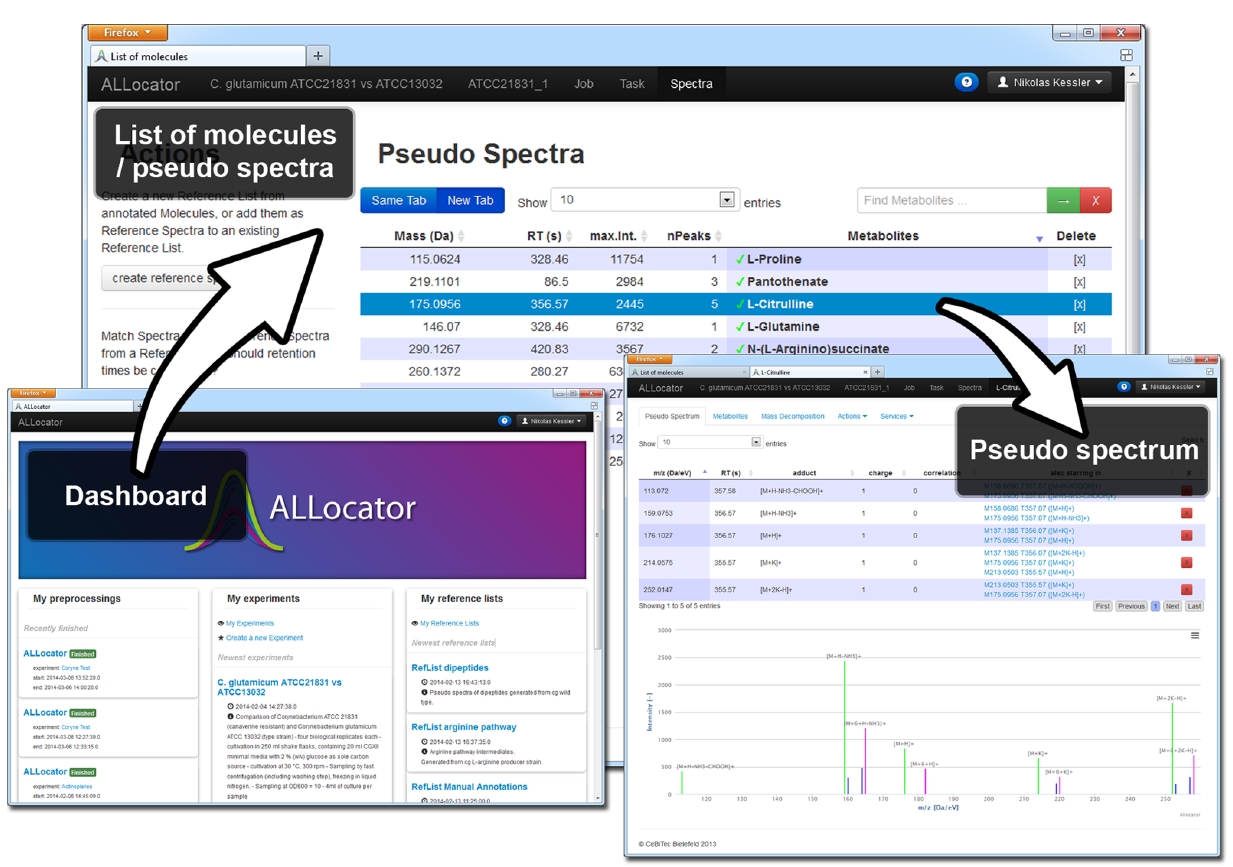
Figure 3. Screenshots from the ALLocator web platform user interface; bottom left: the dashboard that servers as a starting point after log-in; top: The list of molecules or pseudo spectra that were detected in a certain chromatogram; bottom right: A pseudo spectrum view that provides a table of all adducts and fragments, as well as a spectral view of all contributing